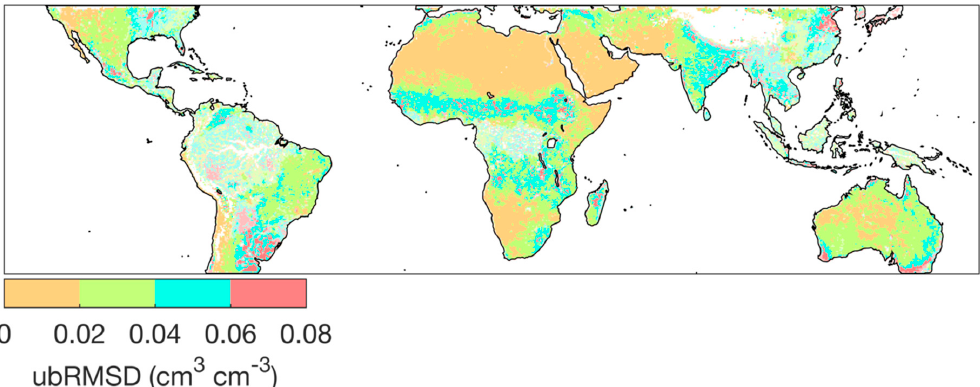
Figure 8. Unbiased root-mean-square difference (ubRMSD) between SMAP and CYGNSS soil moisture retrievals. Regions where SMAP always flags the data as being ‘poor quality’ are semi-transparent, such as the Amazon, Central Africa, Indonesia, Japan, Southeast Asia, and the majority of the Eastern United States. Higher ubRMSD in regions with “good-quality” SMAP data tend to be found in regions that are seasonally flooded or near coastlines. It is possible that in these areas, the seasonal water influence on CYGNSS effective reflectivity may overwhelm the soil moisture signal. Alternatively, it is also possible that the SMAP brightness temperature observations are actually responding to the increase in flooded area instead of soil moisture.